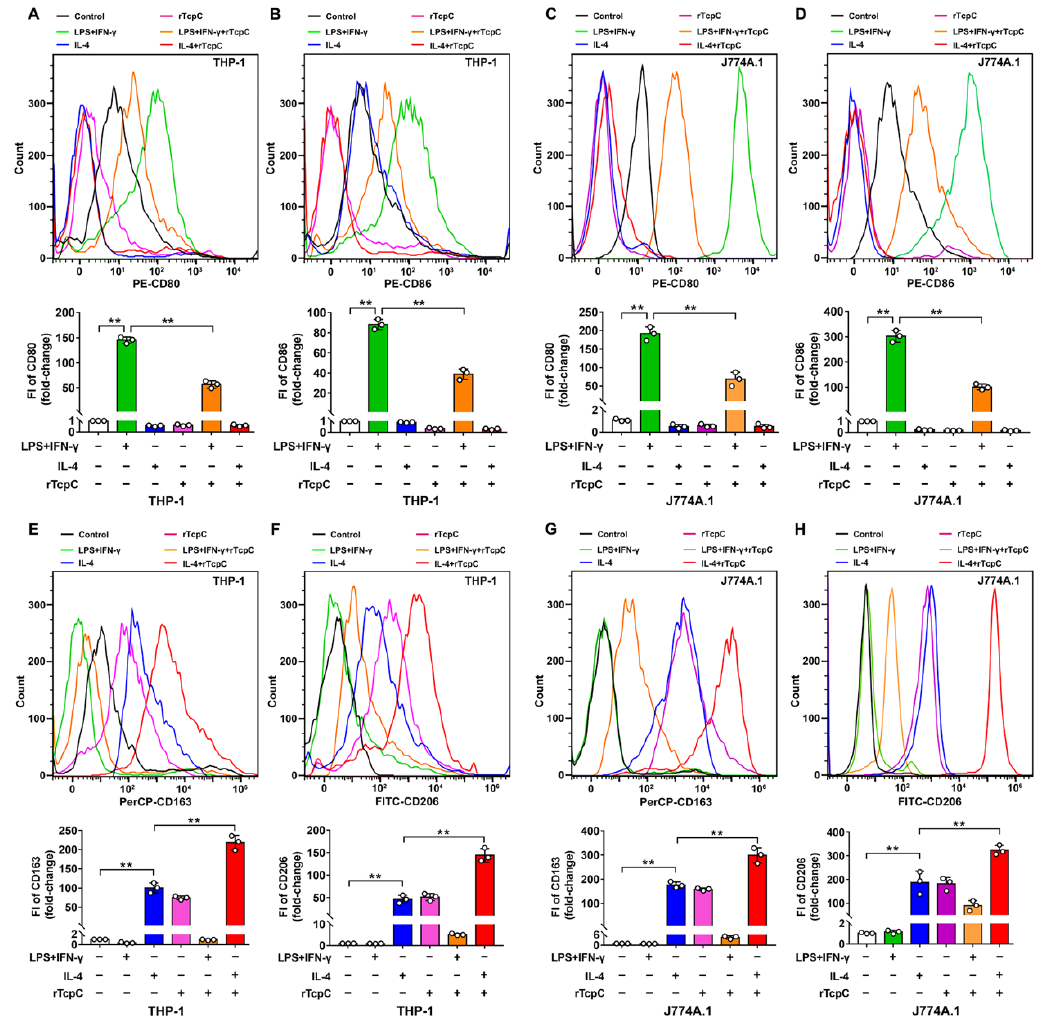
Figure 4. rTcpC inhibits M1 markers CD80 and CD86 but promotes the expression of M2 markers CD163 and CD206 in macrophages. ( A – D ) The effects of rTcpC on M1 surface markers CD80 and CD86 detected by flow cytometry and FI were analyzed by FlowJo v10.0.7 software. ( E – H ) The surface markers CD163 and CD206 of M2 polarized macrophages were detected by flow cytometry. Mean ± SD of three independent experiments are shown. ** : p < 0.01.